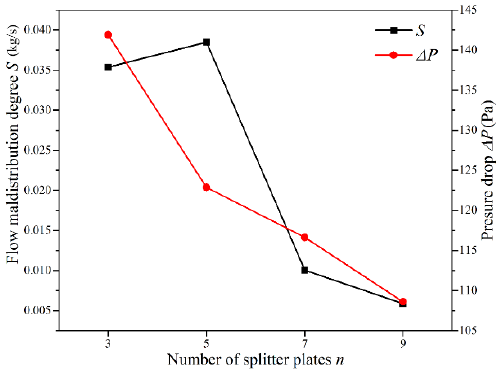
Figure 11. Flow maldistribution degree and pressure drop under different odd numbers of splitter plates.